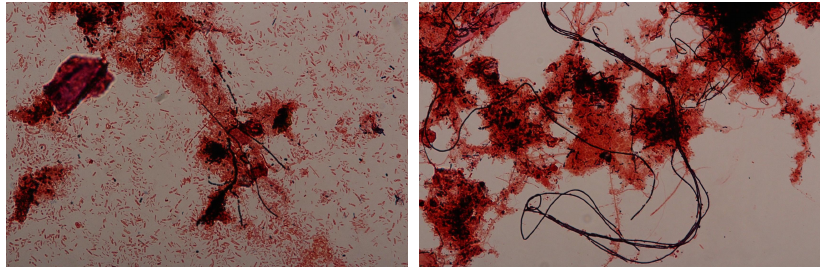
Figure 5. Microscopy (magnified 630 times) of HRAS sludge (left) and conventional activated sludge (CAS) sludge (right), sampled in the first (HRAS process) and second stage (CAS process), respectively, at the WRRF Nieuwveer by Francis